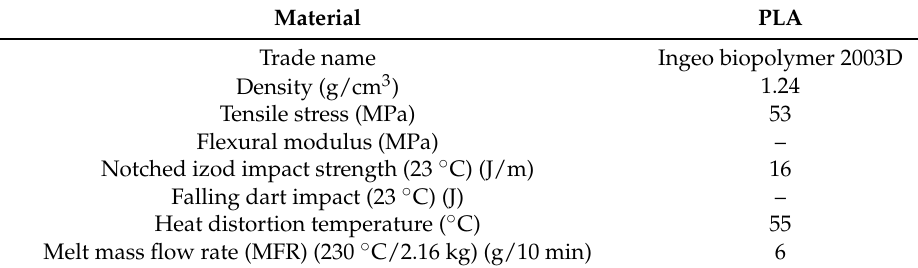
Table 1. Mechanical and physical properties of PLA (according to the datasheet).